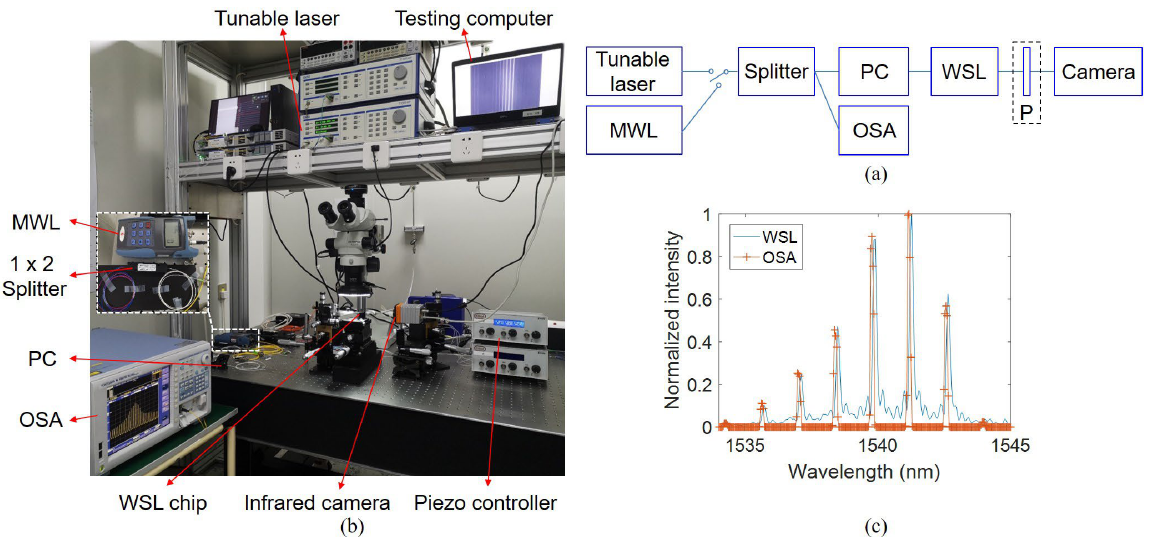
Figure 15. ( a ) Diagram and ( b ) photo of the experimental setup for measuring the optical spectra of tra of an MWL. ( c ) Optical spectra of an MWL measured by WSL2 and a commercial OSA. an MWL. ( c ) Optical spectra of an MWL measured by WSL2 and a commercial OSA. MWL: mul- tiwavelength laser. PC: polarization controller. OSA: optical spectral analyzer. MWL: multiwavelength laser. PC: polarization controller. OSA: optical spectral